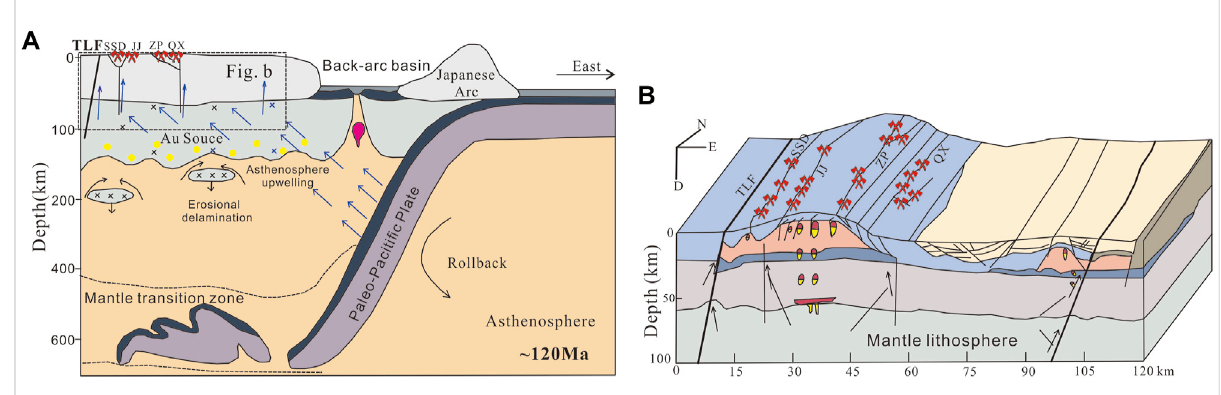
FIGURE 10 Cartoon showing the geodynamics of Jiaodong type gold deposit in Jiaodong gold province. (A) Metallogenic model of Jiaodong gold province; (B) Lithospheric and crustal architecture for the effective deposition of auriferous magma, modi fi ed from Deng et al.